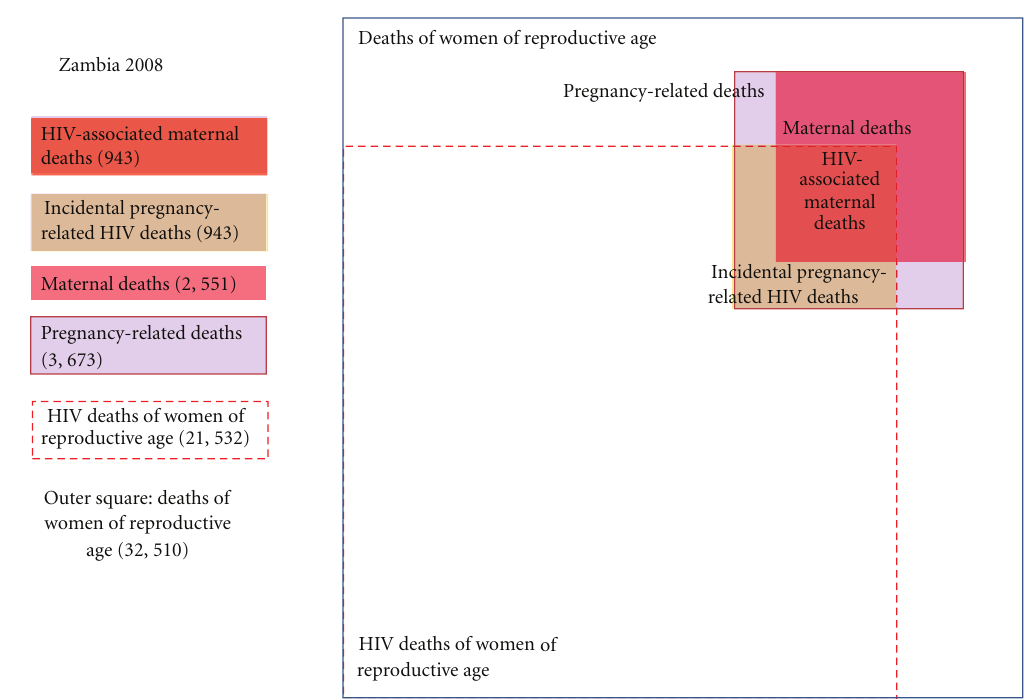
Figure 2: Intersection of HIV and maternal mortality in Zambia, 2008. Source: http://www.who.int/gho/maternal health/ mortality/maternal/en/index.html.